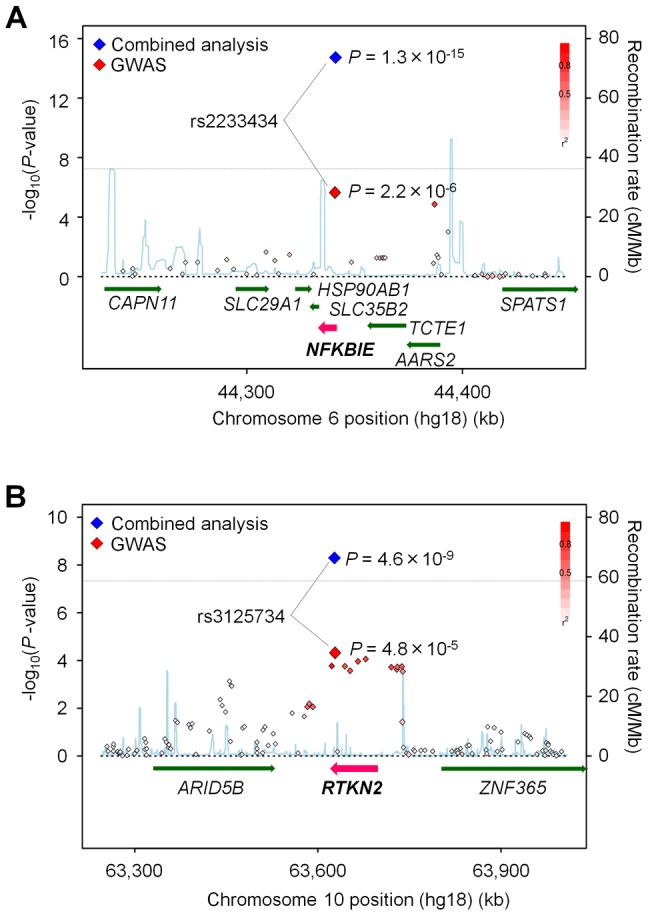
Association plots of NFKBIE and RTKN2 regions.The diamonds represent the -log10 of the Cochran-Armitage trend P-values. Large diamonds show landmark SNPs in NFKBIE (rs2233434: A) and RTKN2 (rs3125734: B). Red: GWAS, Blue: combined analysis. Red colors of each SNP indicate its r2 with landmark SNP. Gray lines indicate the genome-wide significance threshold (P<5×10−8). For each plot, the -log10
P-values (y-axis) of the SNPs are presented according to their chromosomal positions (x-axis). Physical positions are based on NCBI build 36.3 of the human genome. Genetic recombination rates, estimated using the 1000 Genome Project (JPT and CHB), are represented by the blue line.